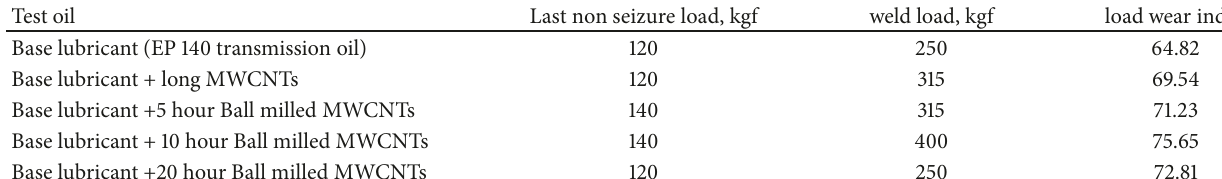
Table 6: Results of EP test conducted as per ASTM D 2783.